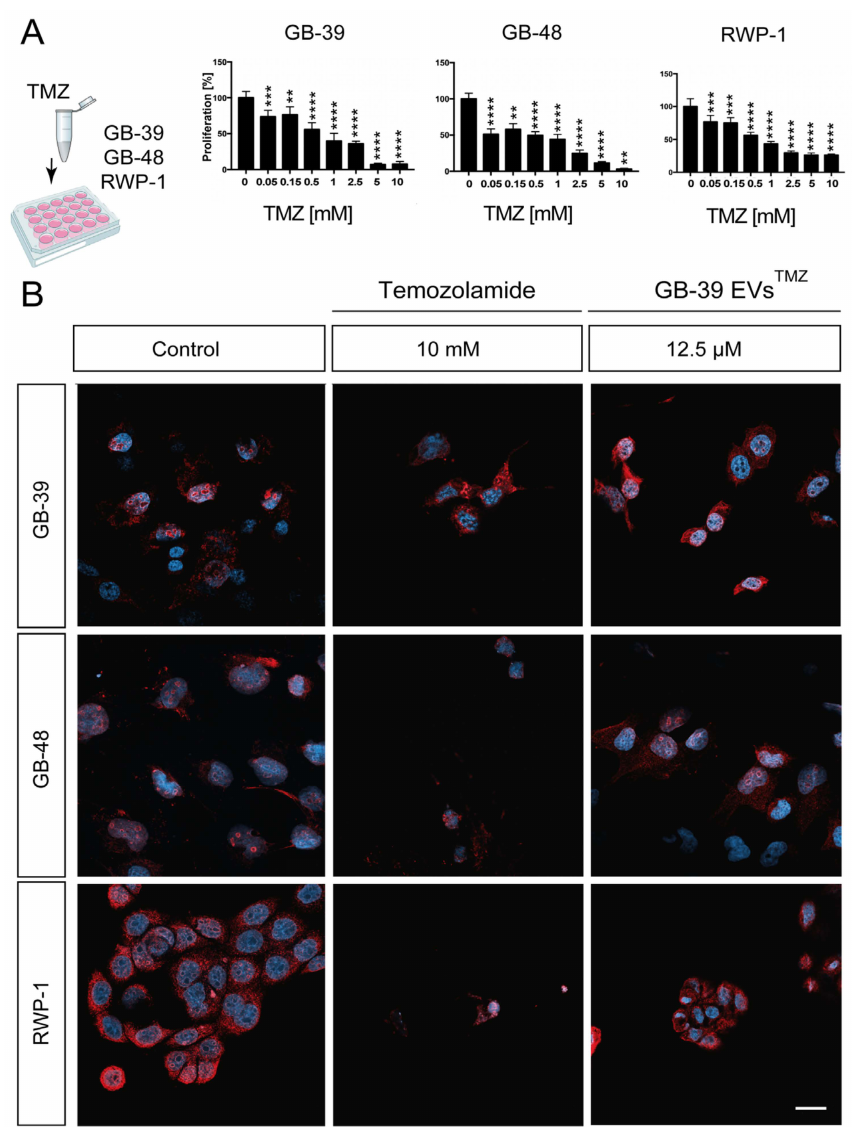
Figure 4. Cell proliferation effect of TMZ in cancer cell lines. ( A ) Cancer cells were treated with increasing concentrations of TMZ, and their proliferation was measured. ( B ) Confocal images showing the expression of a proliferative marker and the decrease in cell density due to the TMZ and GB-39 EVs TMZ effect. Asterisks indicate the statistical significance of the results (** p < 0.01, *** p < 0.001, **** p < 0.0001). Scale bar B, 20 µ m. TMZ, Temozolomide; EVs, extracellular